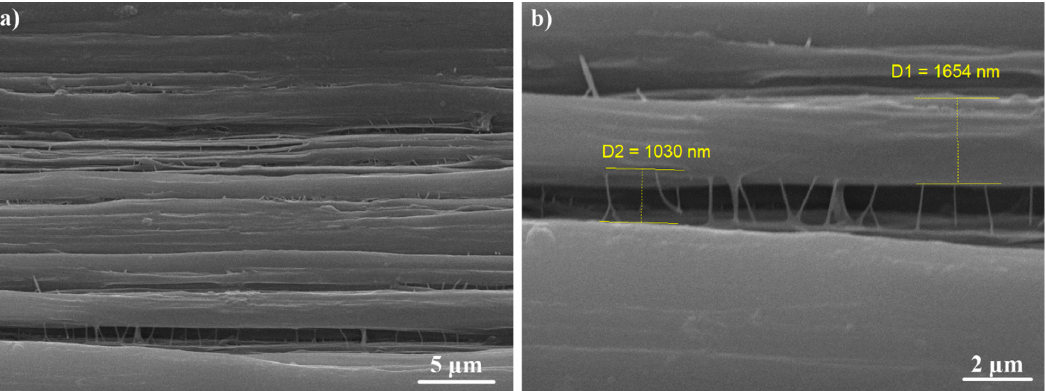
Figure 10. SEM images of fibrillar structure with different magnifications for UHMWPE/PE-wax films at a PE-wax content of 1.0 wt.% with a draw ratio value of 23 obtained by first thermal regime. Tensile direction is horizontal.